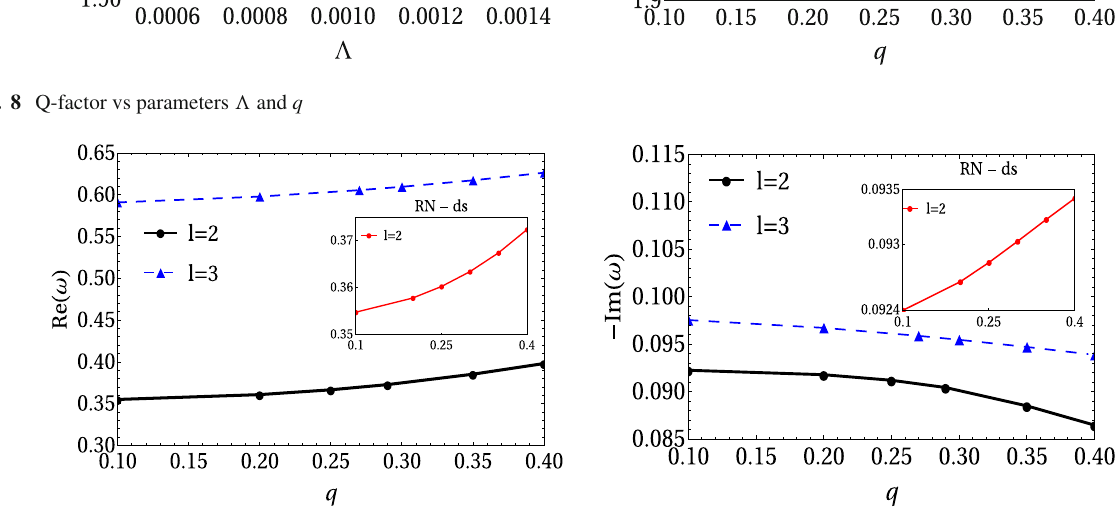
Fig. 9 Variation of Re( ω ) and -Im( ω ) vs q , for (cid:2) = 0 . 002